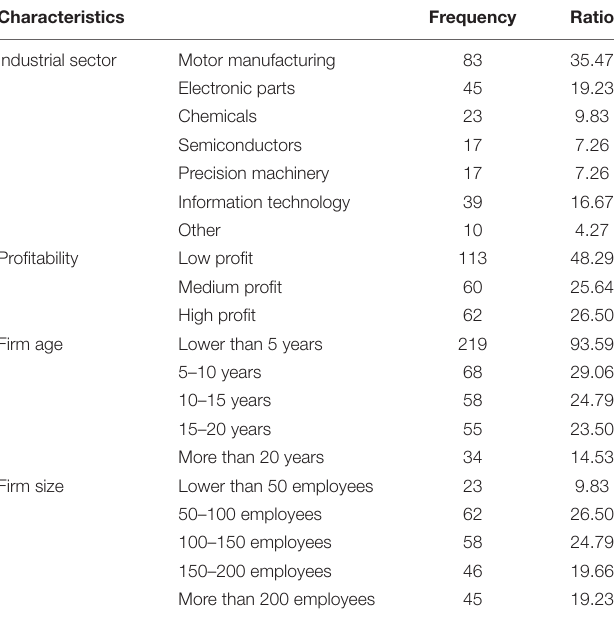
TABLE 1 | Demographic characteristics of